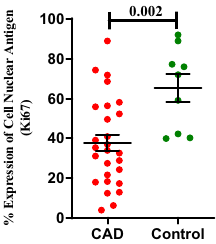
Figure 4. ECFCs proliferation depicted as % expression of cell nuclear antigen Ki67 in CAD and control group. Cell proliferation in terms of expression of Ki67 in ECFCs obtained from CAD and control group (n = 27; n = 09). In histogram Y axis represent rate (%) of expression of cell proliferation marker Ki67 and X axis represent the study groups (CAD and control group). Student t-test was used to assess the significance difference. Data is represented as mean ± SE. Error bar represent standard error of mean; dots represent average values of the parameters obtained from experimental duplicates; p ≤ 0.05 considered statistically significant.